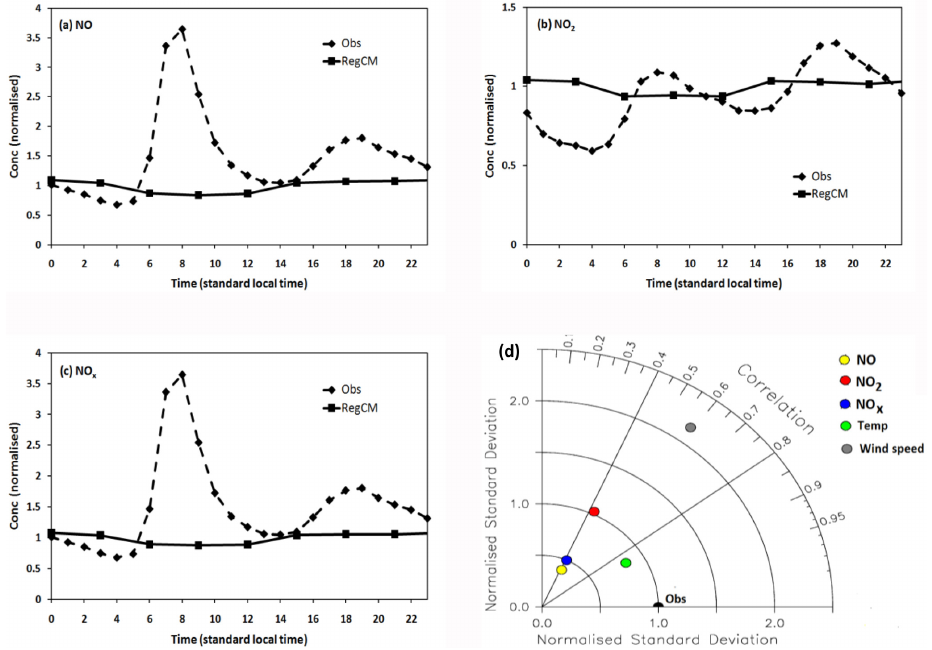
Fig. 6. Comparison of the simulated (RegCM) and observed diurnal variation of (a) NO, (b) NO 2 , and (c) NO x concentrations. (d) shows the Taylor diagram, which uses correlation coefficient and normalised standard deviation to compare variations in the simulated and observed (Obs) daily mean NO, NO 2 , NO x , temperature (Temp), and wind speed. The average observation over the four stations is indicated as Obs. The normalised standard deviations are obtained by dividing the simulated and observed standard deviations with the observed standard